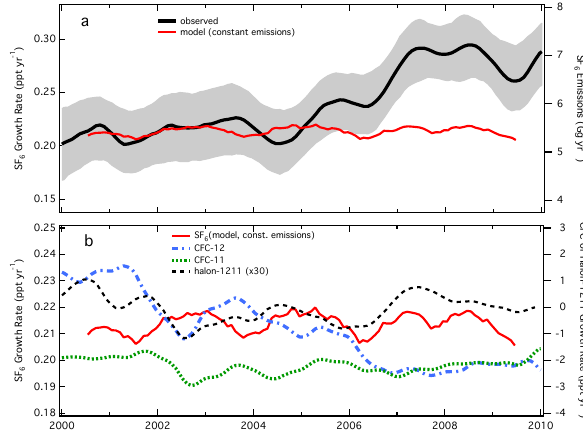
Fig. 10. (a) SF 6 growth rate derived from global mean SF 6 (shaded Figure 10: (a) SF 6 growth rate derived from global mean SF 6 (shaded region is 2 σ ), along with 566 region is 2- σ) , along with corresponding emissions (Ggyr − 1 ) cal- corresponding emissions (Gg yr -1 ) calculated with a 2-box model (Geller et al., 1997) and with 567 culated with a 2-box model (Geller et al., 1997) and with SF 6 SF 6 growth rate derived from model results at four sites using constant SF 6 emissions (solid red) 568 growth rate derived from model results at four sites using constant to assess transport-driven changes in the SF 6 growth rate; (b) observed growth rates of CFC-12 569 (blue), CFC-11 (green), halon-1211 (black, detrended) derived from global mean data, and 570 SF 6 emissions (solid red) to assess transport-driven changes in the model SF 6 repeated from (a). 571 SF 6 growth rate; (b) observed growth rates of CFC-12 (blue), CFC- 11 (green), halon-1211 (black, detrended) derived from global mean data, and model SF 6 repeated from (a)